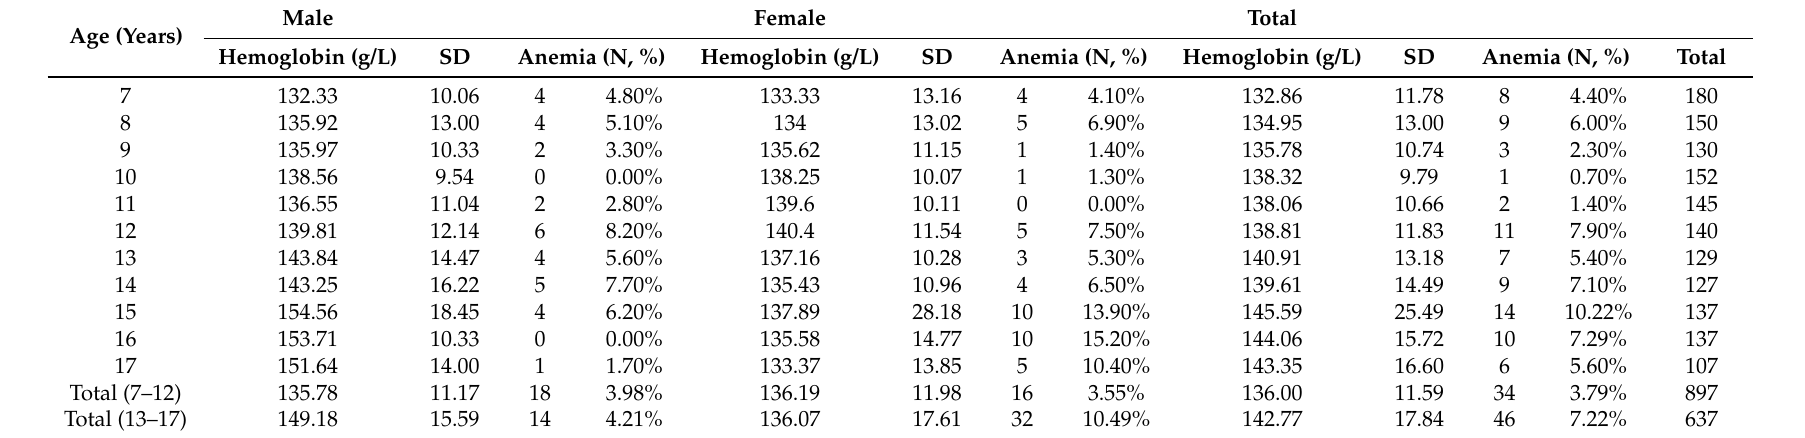
Table 3. The distribution of hemoglobin and anemia in Zhejiang province stratified by age and